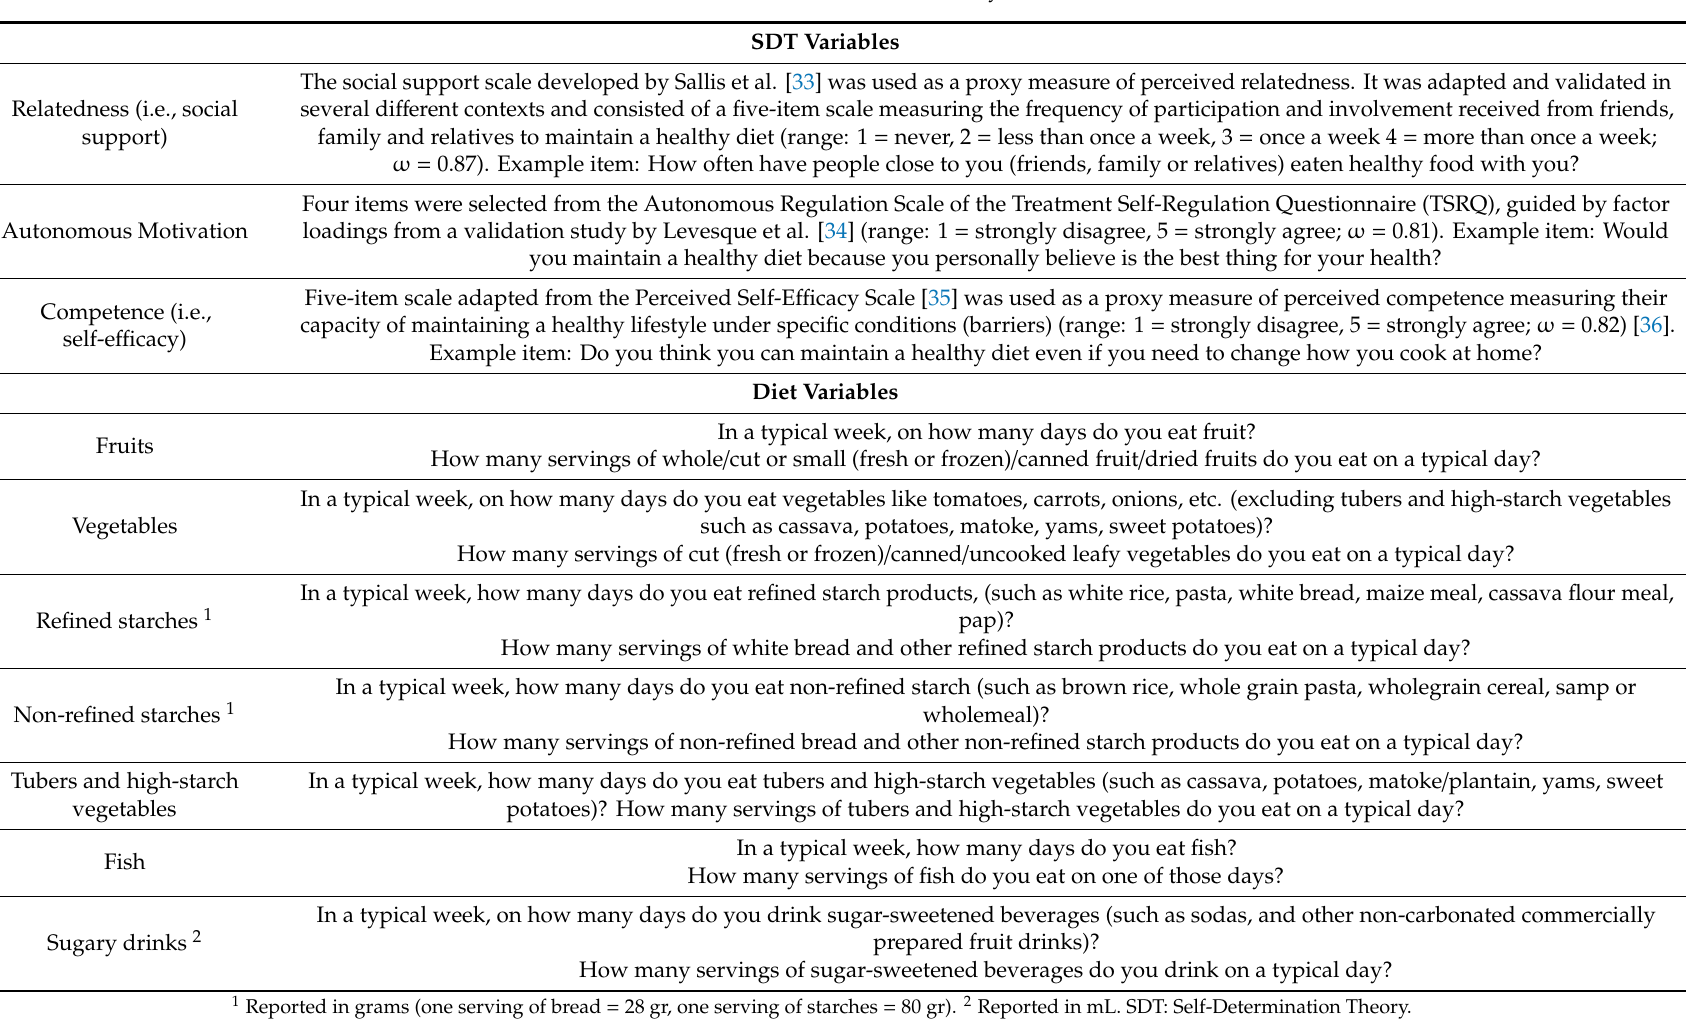
Table 1. Variables used in the